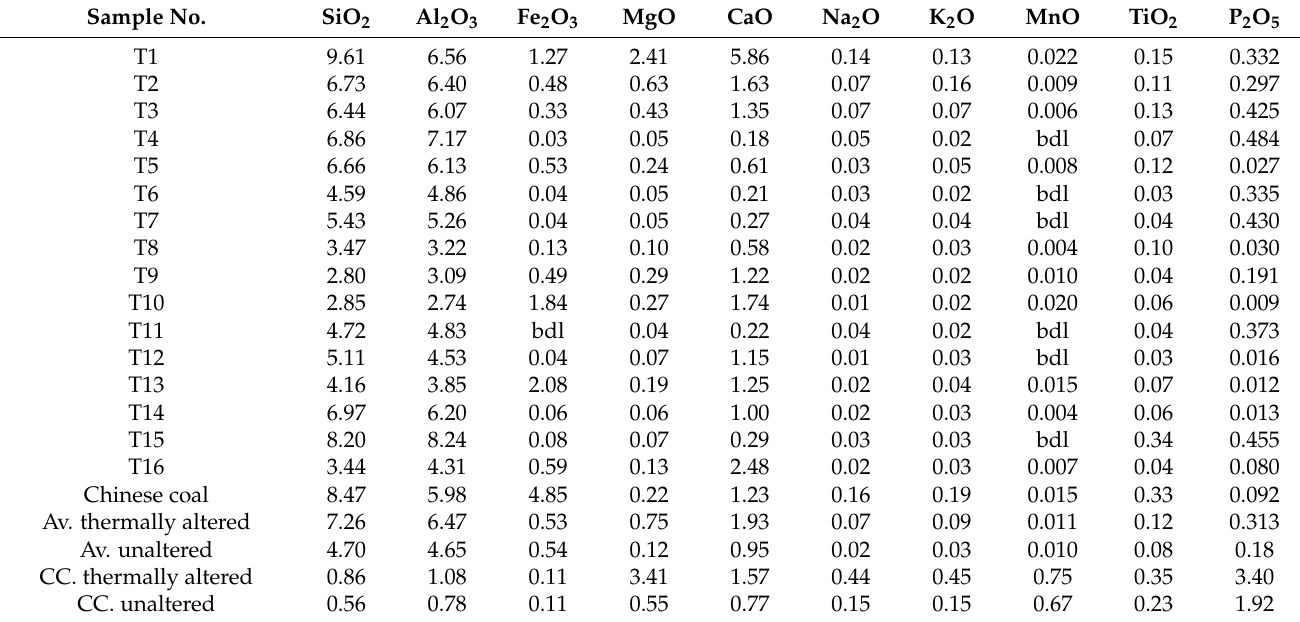
Table 6. Contents of major element oxides in the Tashan coal (wt.%, whole coal basis). Sample